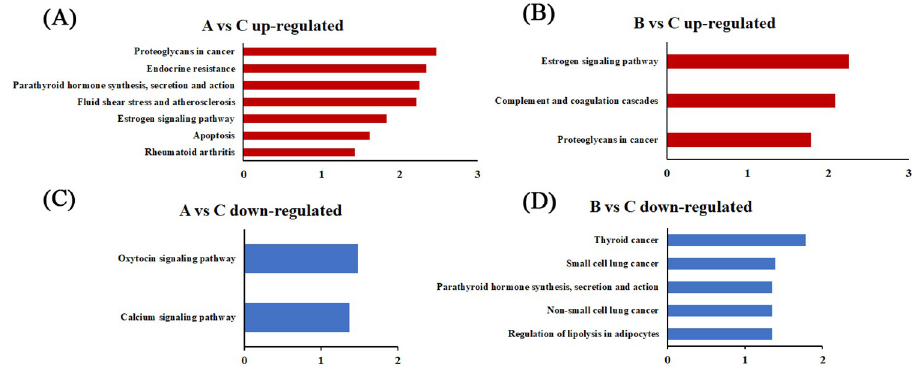
Fig 2. Pathway analysis of DEGs. A. KEGG enrichment analysis of upregulated genes for chronic low-temperature acclimation group (-log 10 (p-value) > 1.3). B. KEGG enrichment analysis of downregulated genes for chronic low- temperature acclimation group (-log 10 (p-value) > 1.3). C. KEGG enrichment analysis of upregulated genes for acute short cold stress group (-log 10 (p-value) > 1.3). D. KEGG enrichment analysis of downregulated genes for acute short cold stress group (-log 10 (p-value) >